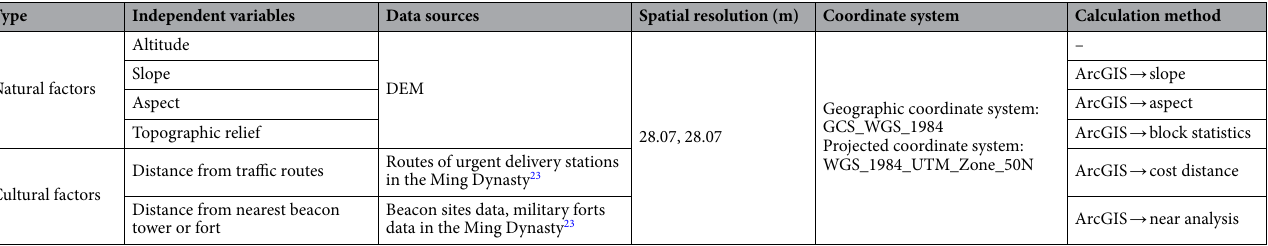
Table 1. Alternative independent variables. Topographic relief and slope were the main two factors considered in the calculation of cost distance, and the equation used to calculate the cost distance was “cost distance = topographic relief × 0.4 + slope × 0.6” 24